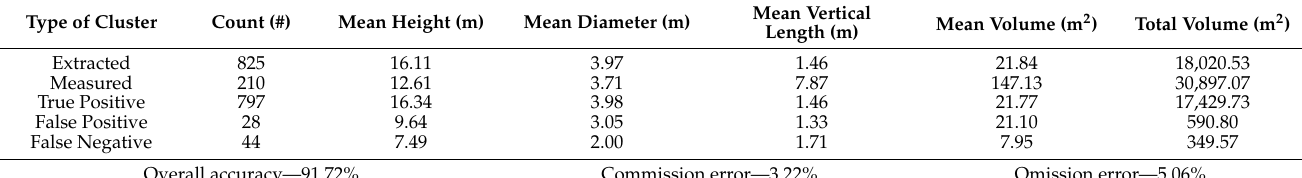
Table 1. Differences between the amount of extracted, measured, true positive, false positive, and false negative clusters. Statistics related to the heights and dimensions of each type of cluster and cluster matching results are also shown.